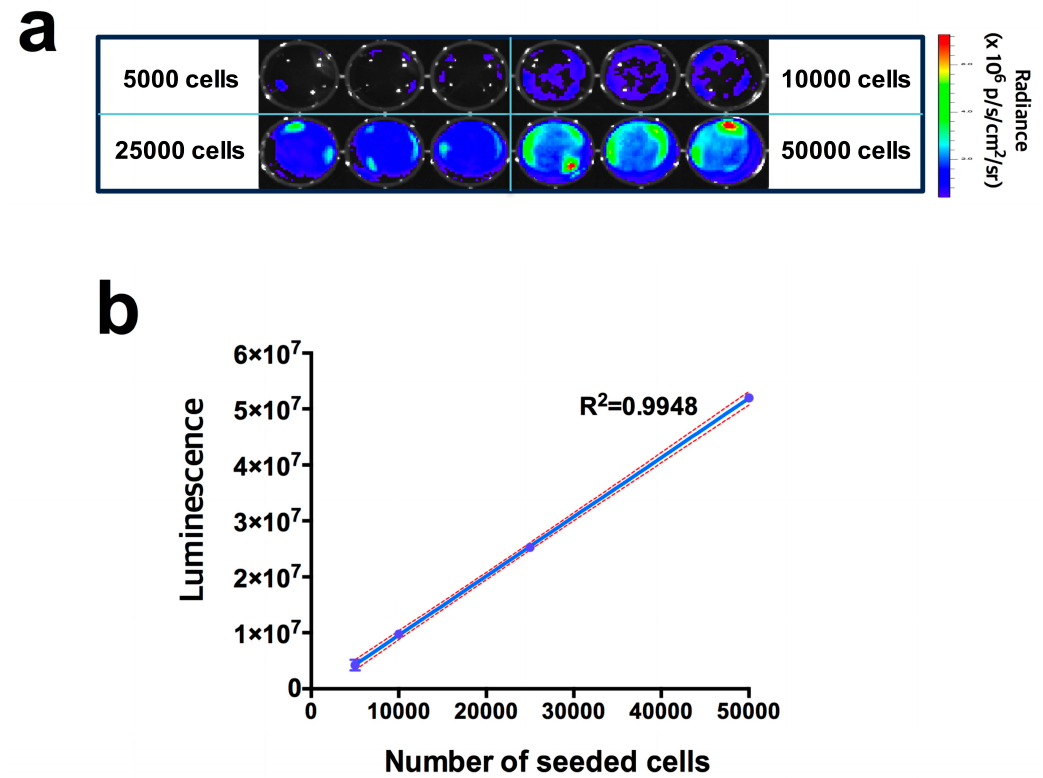
Figure A2. Generation of a standard curve of bioluminescence. ( a ) 143B-luc cells were added to wells of plates at the cell numbers were indicated, D-luciferin was added, and the bioluminescent signal obtained was quantified using the IVIS spectrum. ( b ) Graph of bioluminescent signal versus number of seeded cells. Bars represent SEM (R 2 = 0.9948). Table A1. Comparison of bioluminescence versus classical migration assays.